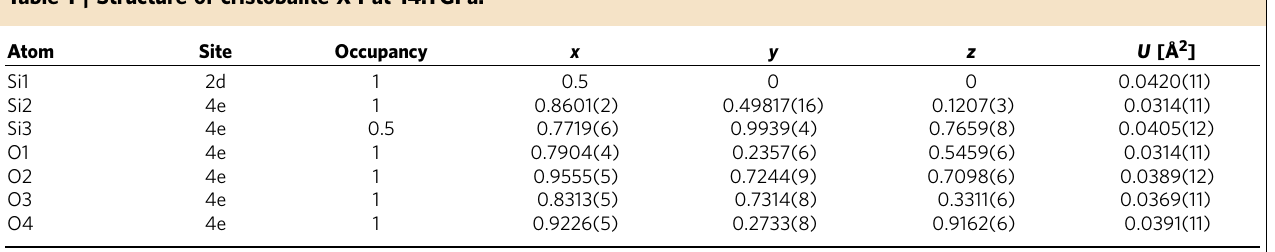
Table 1 | Structure of cristobalite X-I at